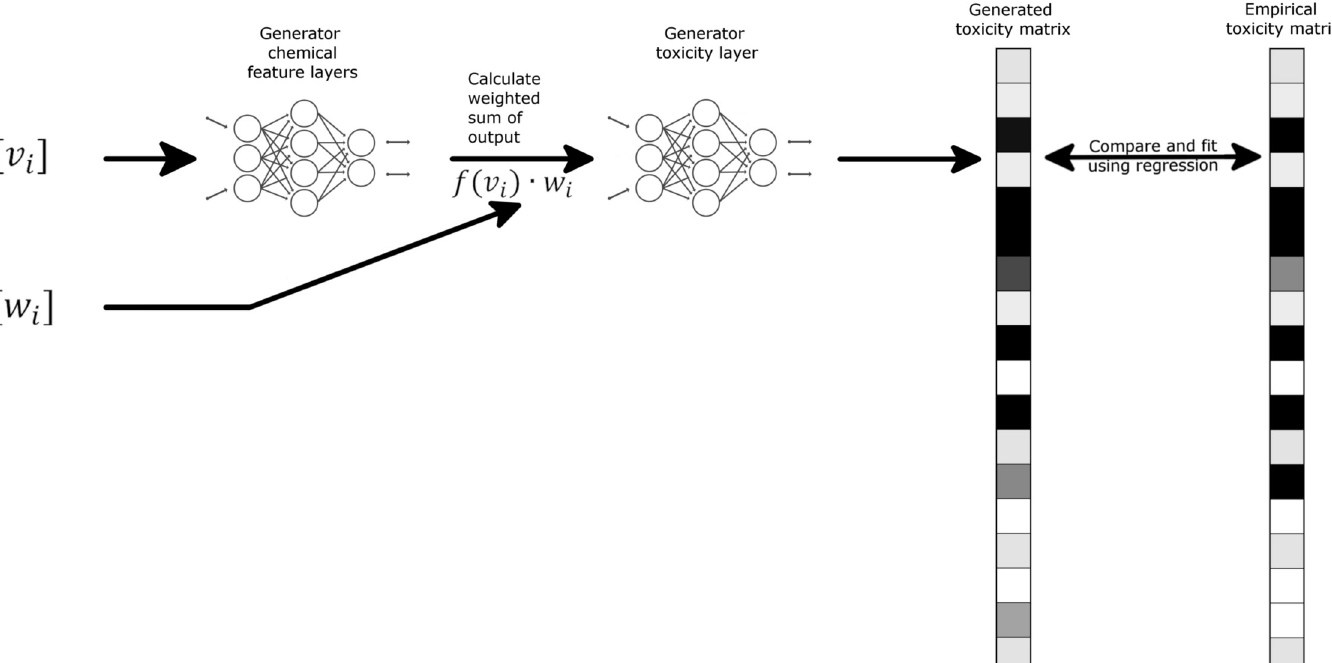
Fig 1. Regression generator diagram. Schematic representation of Go-ZT architecture showing chemical structural input represented as weights (w i ) and views (v i ) matrices passed through two fully connected neural networks to produce a predicted toxicity matrix. Darker matrix shading indicates higher toxicity values.